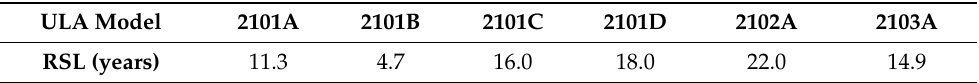
Figure 15. Reliability index as a function of time. Table 15. Predicted remaining service life of Riser based on the assumption of target β of